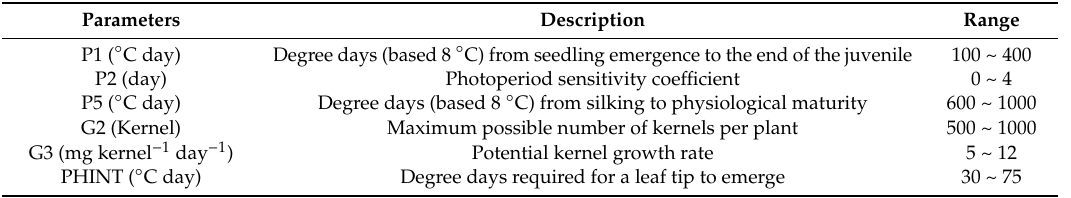
Table 2. Genetic parameter and ranges for summer